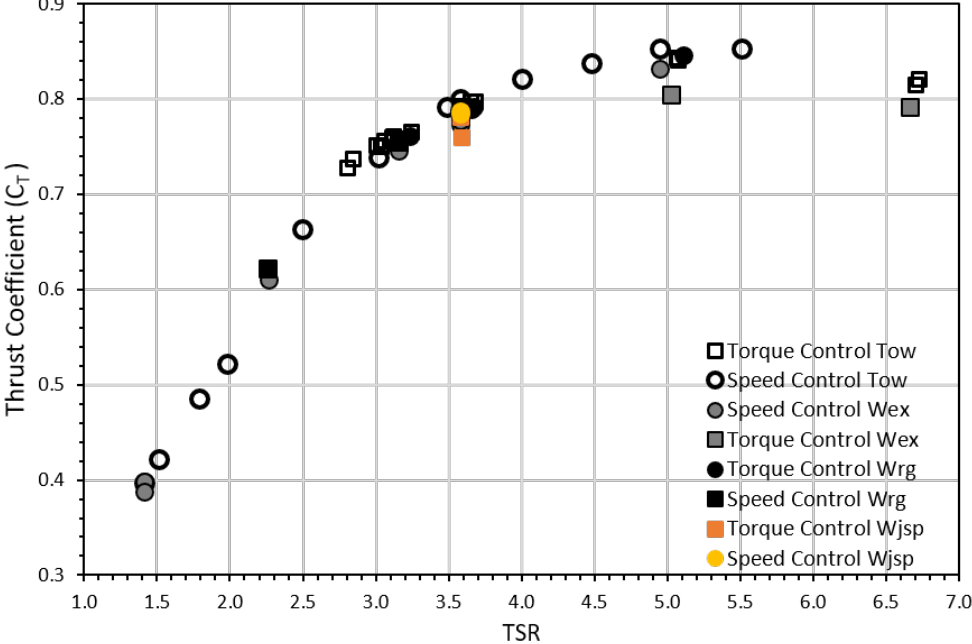
Figure 7. Thrust coefficient ( C T )—Tip speed ratio (TSR) curve including all the test cases for both control